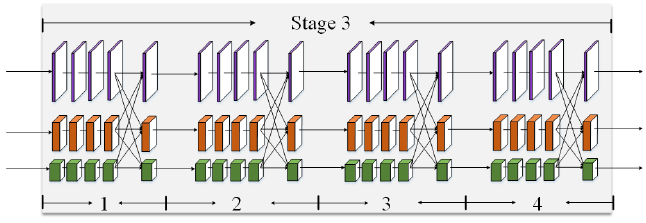
Figure 3. The third stage of the used HRNet connecting 4 modules in series.